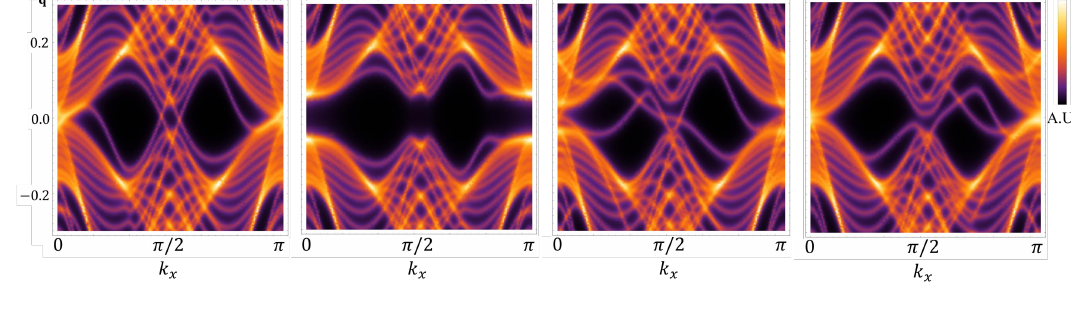
) = ( − i , − i , − i ) , , Φ , Φ 1 ↓ 2 ↓ 3 ↓